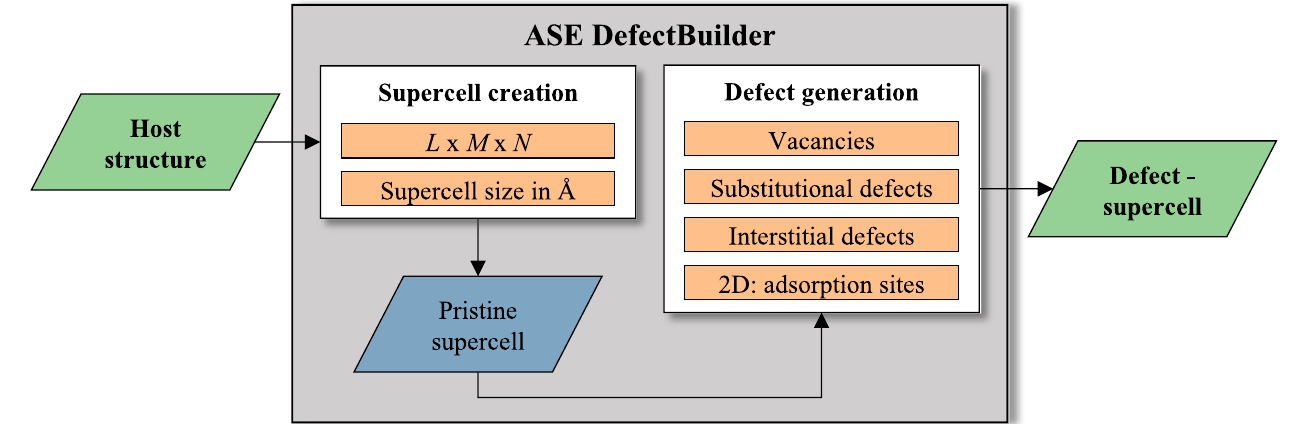
Fig. 1 Structure of the DefectBuilder class in ASE. The DefectBuilder takes a host input structure in the commonly known formats used by ASE and sets up a pristine supercell (which can either be de fi ned by simple L x M x N repetitions or a physical minimum defect-defect distance criterion). Afterward, the module generates different kinds of single point defects and fi nally returns the desired defect structures in their respective